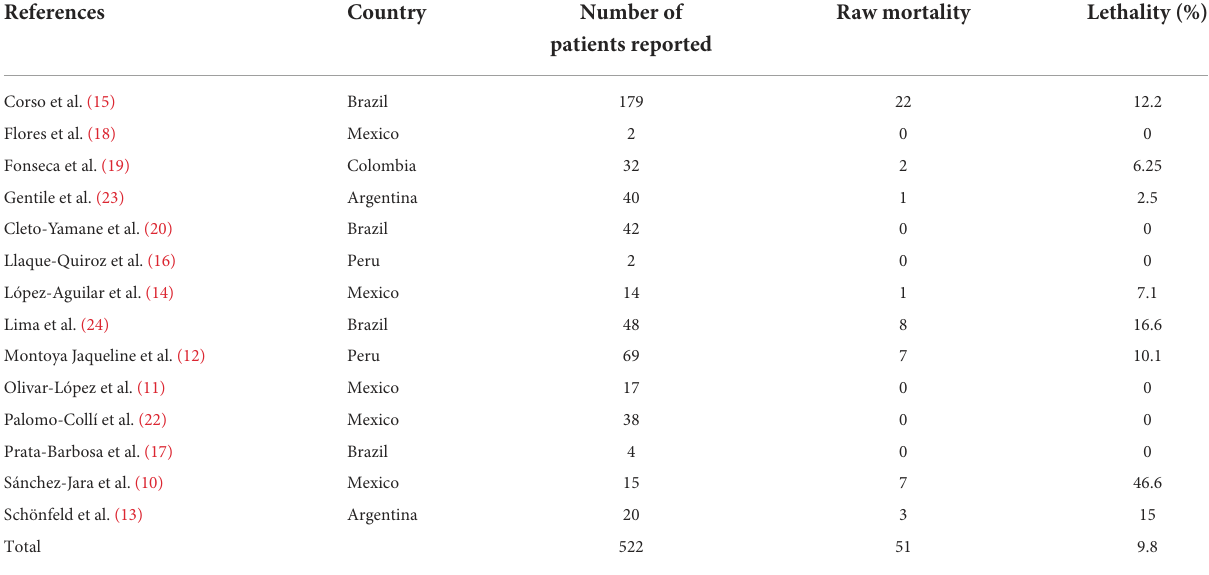
TABLE 1 Patients, mortality and